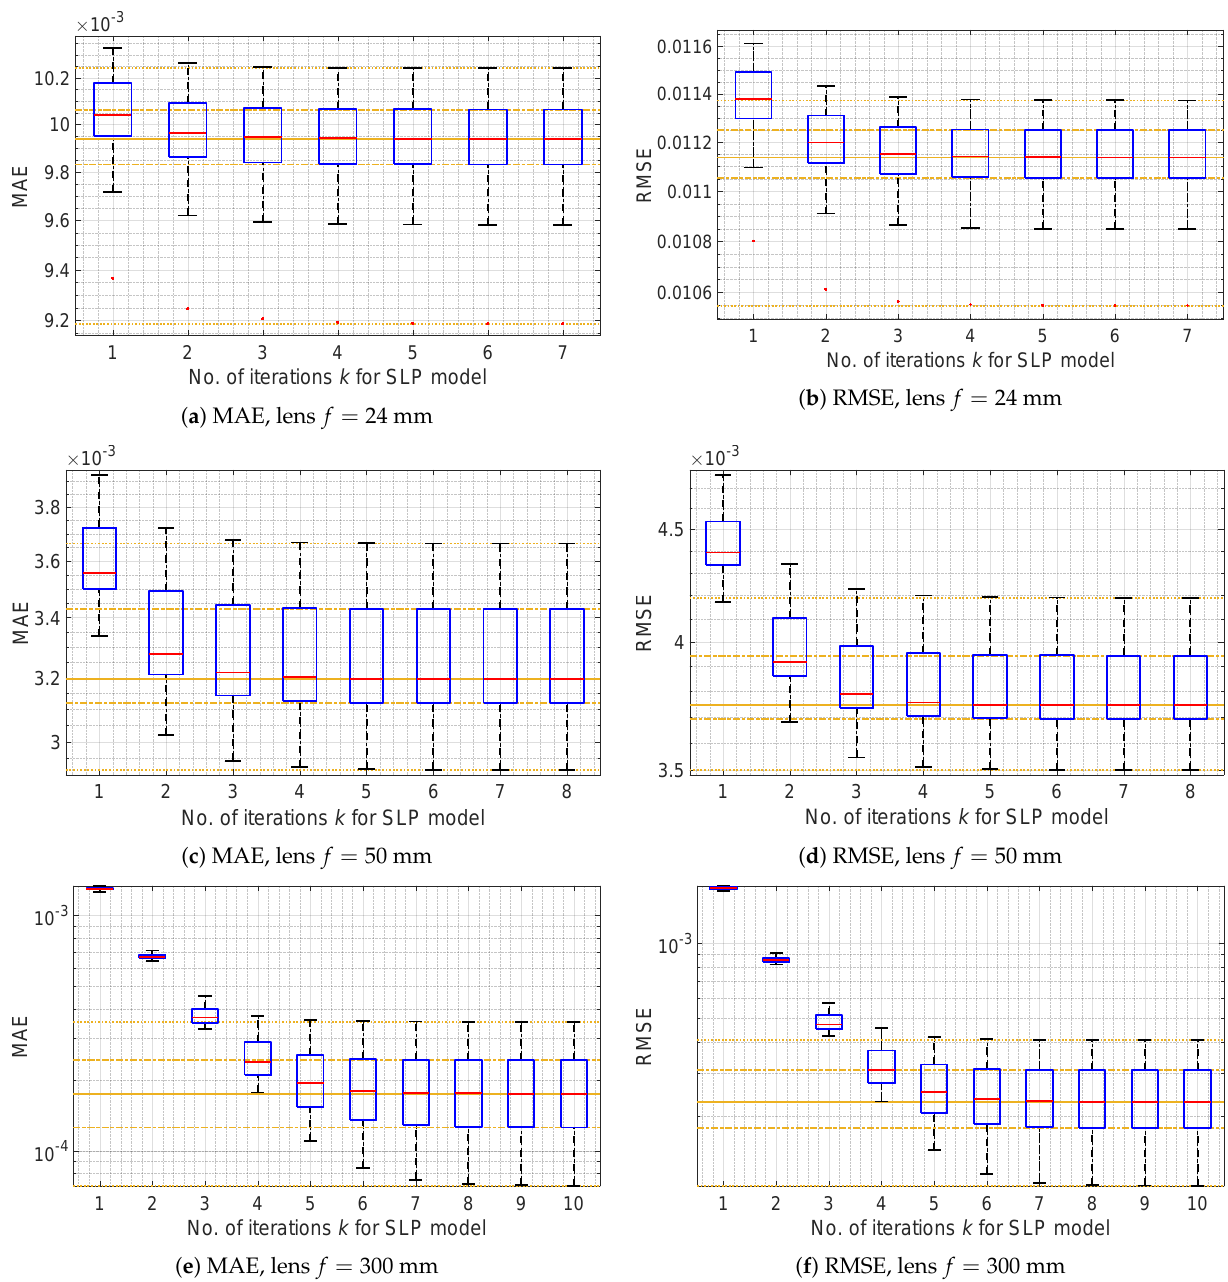
Figure 1. Comparison of MAE and RMSE error values obtained for the LP, SLP, and SNILP models and simulated vignetting of lenses with different focal length f ; results for I V contained with Gaussian mixture noise (A5) for σ add = 5% and σ multi = 10%. Results for the LP model are equal to results from the SLP model for k = 1. Results for the SNILP model are presented as orange lines, whereas lines, from bottom to top, represent minimal, first quartile, median, third quartile, and maximal of error